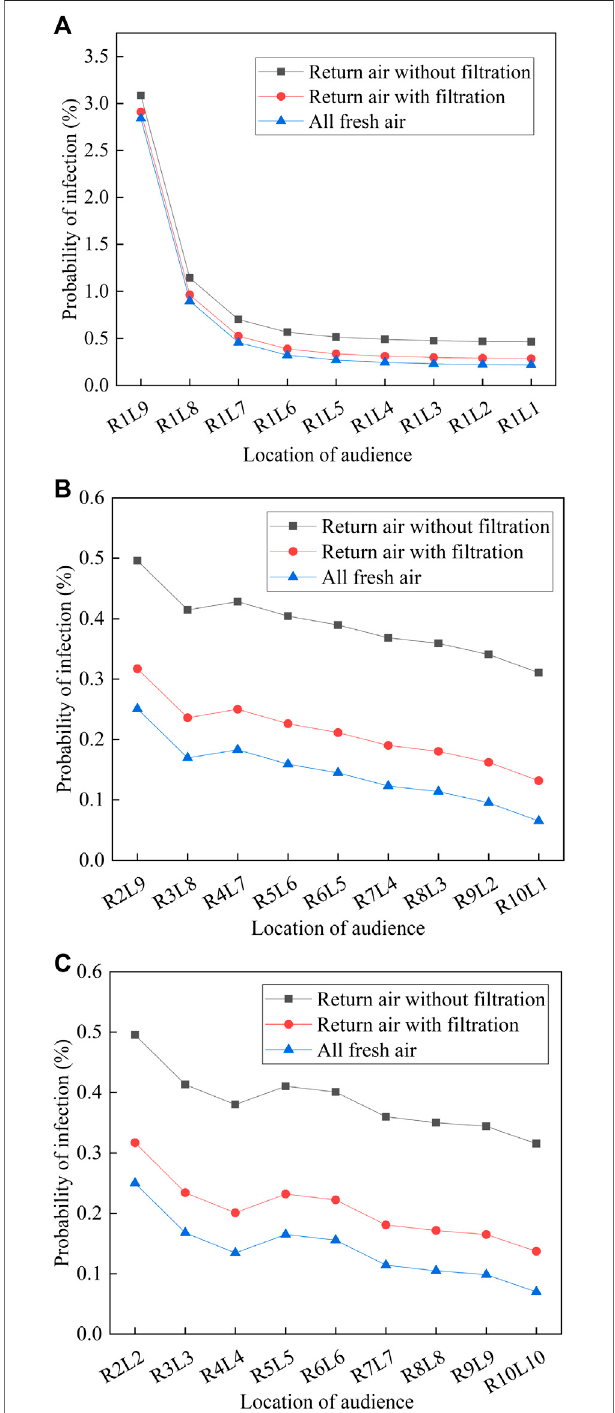
FIGURE8| Probabilityofinfectionunderthreedifferentsupplyairstates: (A) Line 2; (B) Line 3; (C) Line 4